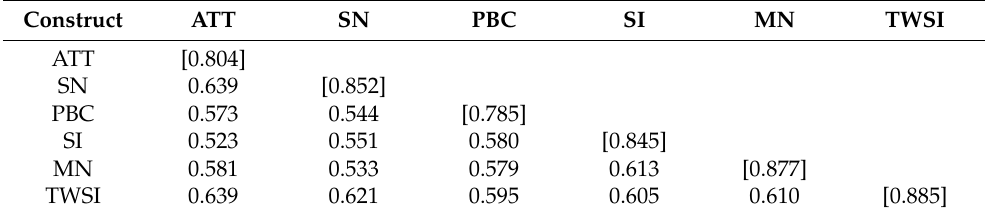
Table 3. Results of discriminant validity.